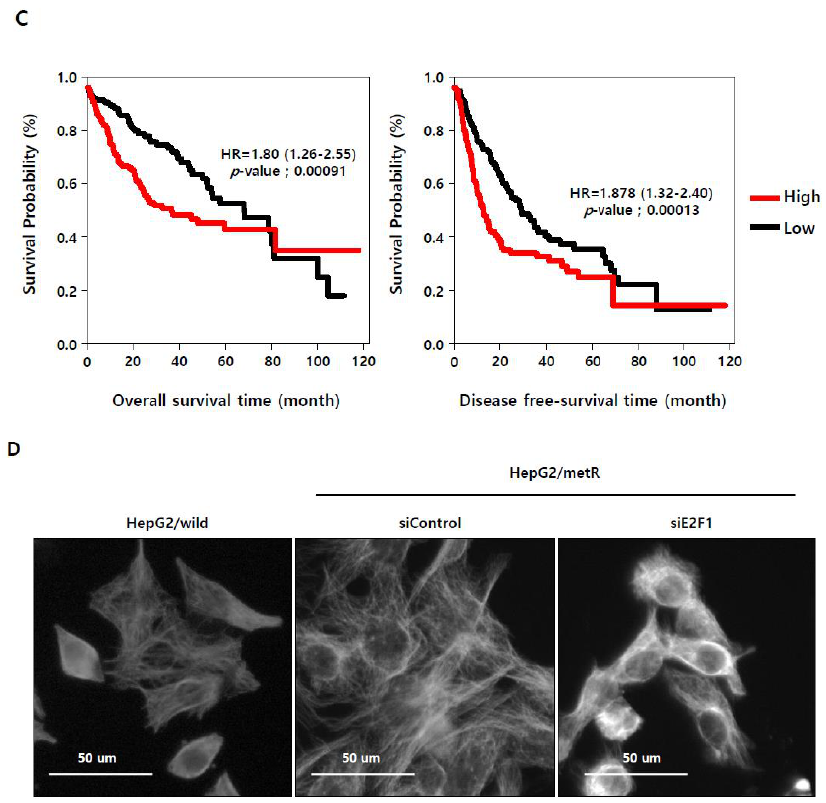
Figure 4. Role of E2F1 pathway in cell motility regulation. ( A ) Migration and invasion assays of E2F1-depleted HepG2/metR cells with or without exogenous L -lactate (30 mM). Original magnification (40×). ( B ) Migration and invasion assays of E2F1-depleted Huh7 cells. Original magnification (40×). ( C ) Overall survival and diseases-free survival rates of hepatocellular carcinoma patients depending on E2F1 activity in TCGA-LIHC (372 patients) cohort. Hazard Ratios with 95% confidence interval are also shown. ( D ) Immunofluorescence imaging of α -tubulin (white) protein in E2F1-depleted HepG2/metR cells is compared with those in control HepG2/metR and parental HepG2 cells. Experiments were conducted in triplicates, and the data shown represent a typical experiment. All quantitative data were obtained from three independent experiments, and shown as mean ± SD. * p < 0.05 and ** p < 0.01 vs. control by Student’s t -test.